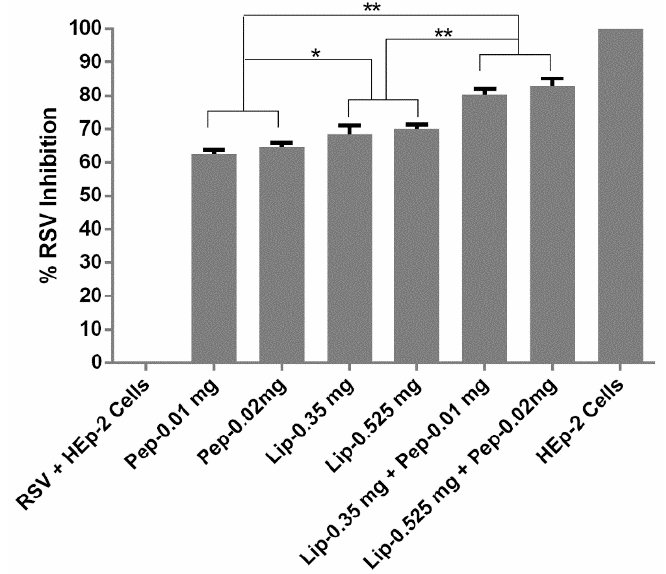
Figure 5. Screening of peptide, liposomes, and peptide encapsulated against respiratory syncytial virus (RSV). Plaques were counted, and the mean plaque was a count of each sample, which was expressed as a percentage of the mean count of the control. ( n = 3 ± SD). Significant differences between the samples represented as * p < 0.05 and ** p < 0.01.